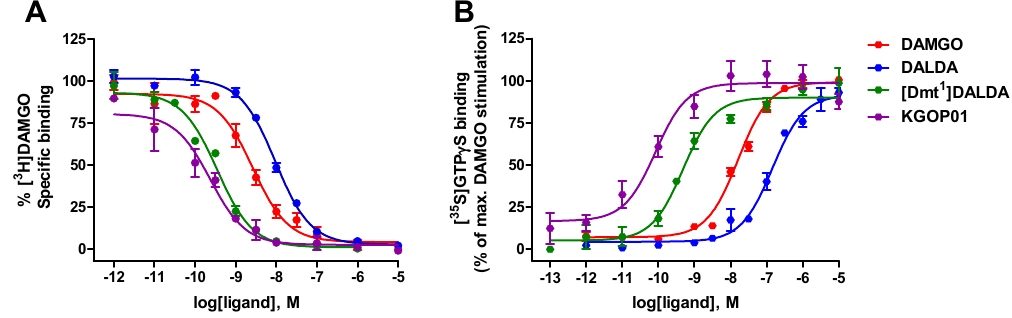
Figure 2. In vitro activity profiles of DAMGO, DALDA, [Dmt 1 ]DALDA, and KGOP01 to the human MOR (hMOR). ( A ) Binding of tested peptides to the MOR was determined in competitive radioligand binding assays using CHO-hMOR cell membranes. ( B ) Stimulation of [ 35 S]GTP γ S binding by tested peptides was determined in the [ 35 S]GTP γ S binding assay using CHO-hMOR cell membranes. Values are expressed as the mean ± SEM (n = 3-4 independent experiments).